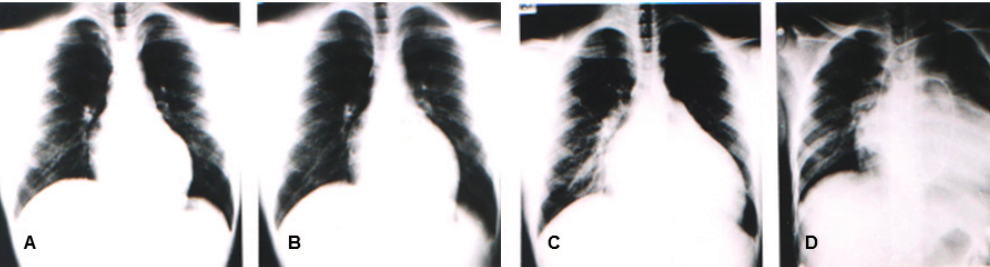
Figure 3. Chest radiographs of a patient having mild BMD with DCM and a l1 insertion mutation in the muscle exon 1 of the DMD gene at 12 years ( A ), 15 years ( B ), 17 years ( C ), and 18 years ( D ). Swan ganz catheter is seen on the chest radiograph ( D